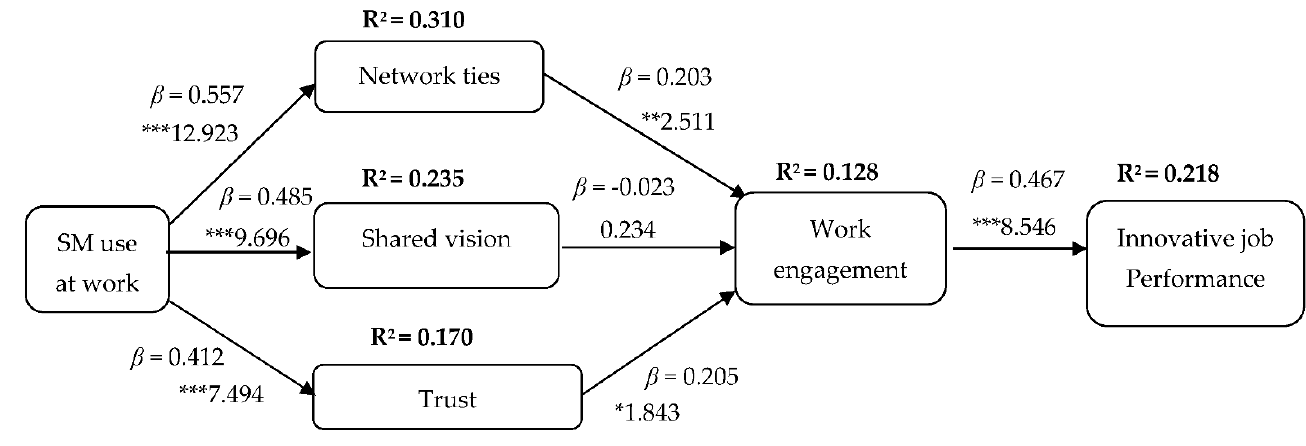
Figure 2. Structural Model. Table 6. The result of the coefficient determination (R Square), Effect Size (f Square), and predictive